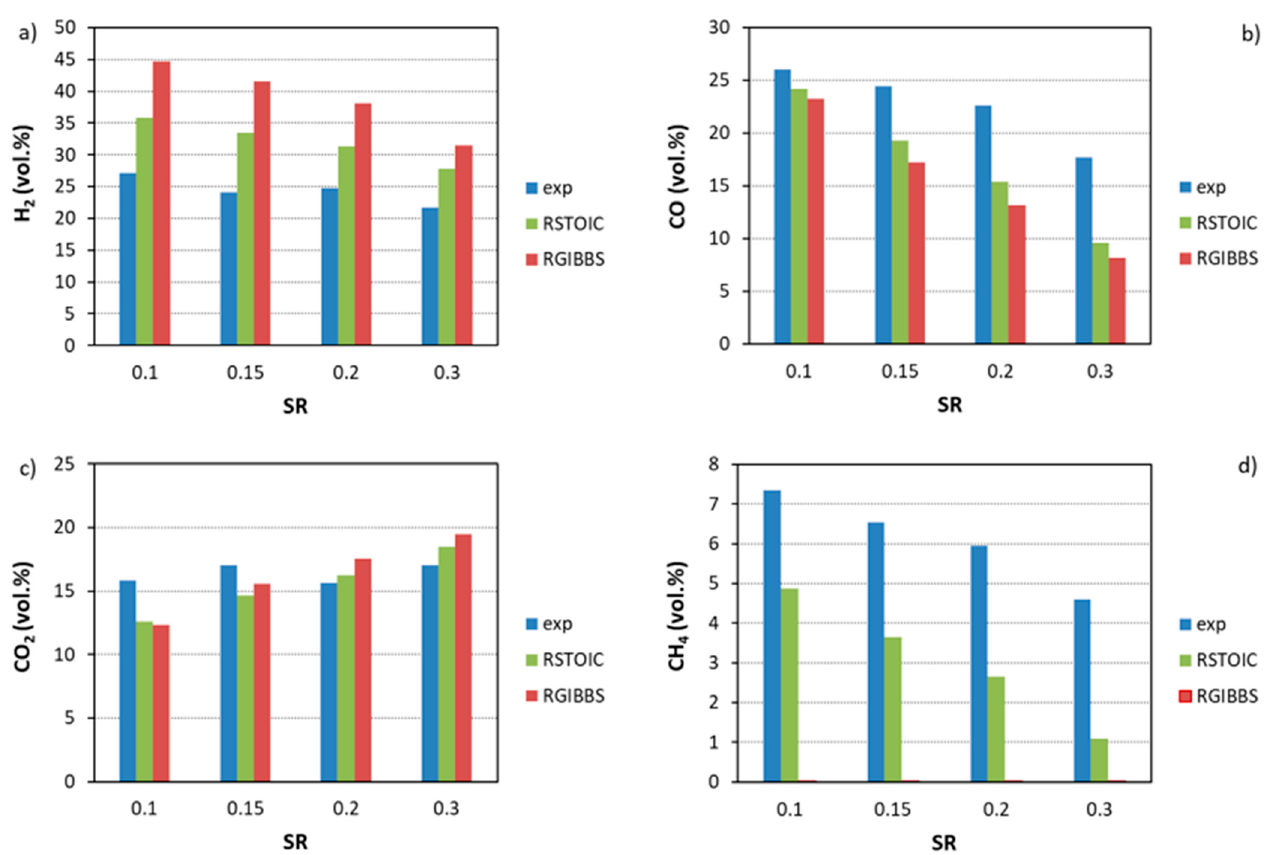
Figure 3. Comparison between the experimental results for the produced gas composition at different stoichiometric ratios during gasification of PKS using 70 vol.% steam at 900 °C, and the predictions obtained with stoichiometric and non-stoichiometric models: ( a ) H 2 , ( b ) CO, ( c ) CO 2 and ( d ) CH 4 (CH 4 values of RGIBBS model are negligible, typically below 10 − 3 ).